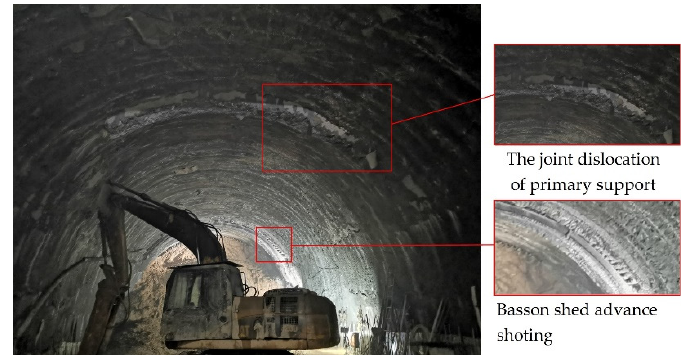
Figure 4. Surface morphology of tunnel support structure at the initial stage.